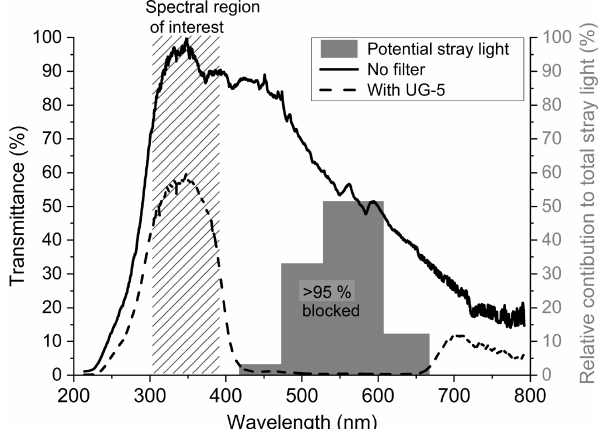
Figure 4. Stray-light reduction in the UV by using a UG-5 filter. The distribution of the relative contribution of different spectral areas to the total stray light as determined with a set of bandpass filters is shown in grey bars. The two curves show the lamp spectrum deter- mined with setup HD and a classical 800 → 200 fibre configuration by a measurement on the SC plate with (dashed) and without (solid) a UG-5 bandpass filter between the light source and sending